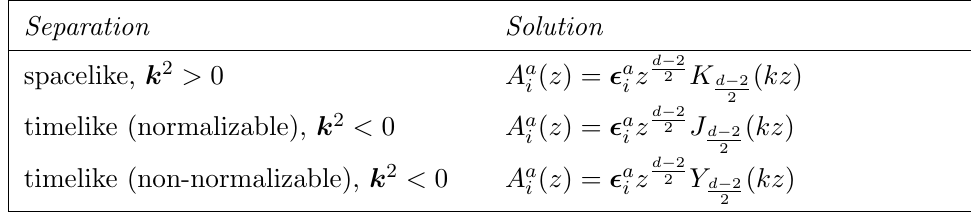
Table 2 . Solution to the equations of motion for gauge